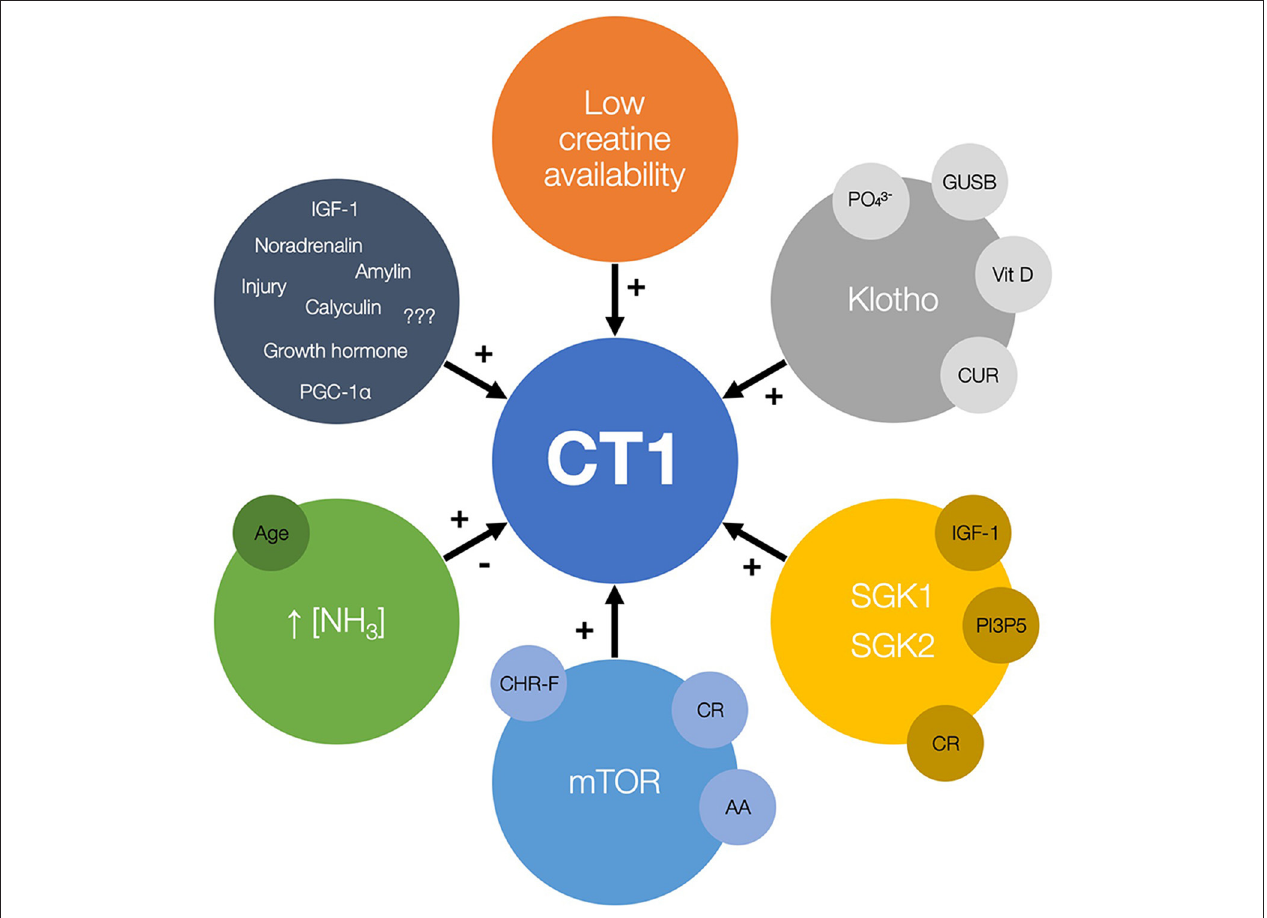
FIGURE 1 | The candidate regulators of creatine transporter (CT1) function and expression, with possible nutrition-related cofactors and modulators (small circles). The plus sign ( + ) indicates the stimulation of CT1 activity while the minus sign (–) indicates possible inhibition of CT1 function. GUSB, β -glucuronidase; Vit D, vitamin D; CUR, curcumin; SGK, serum and glucocorticoid regulated kinases; IGF-1, insulin-like growth factor 1; PI3P5, phosphatidylinositol-3-phosphate-5-kinase; CR, calorie restriction; mTOR, mammalian target of rapamycin; AA, amino acids; CHR-F, carbohydrate-restricted feeding; PGC-1a, peroxisome proliferator-activated receptor- γ coactivators